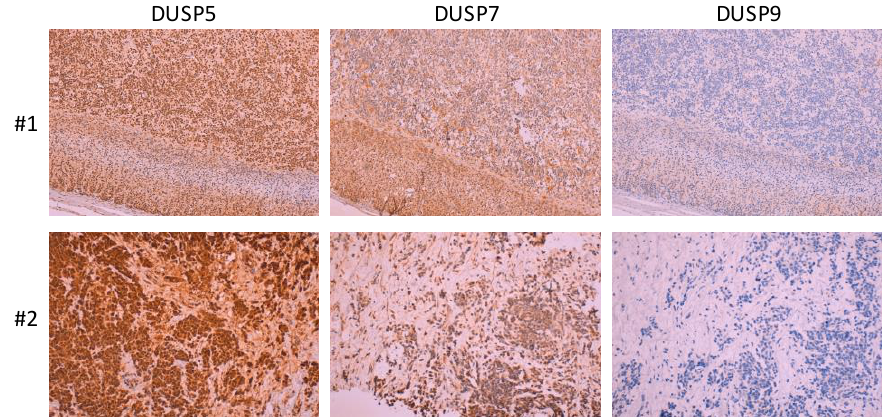
Figure 3. Immunostaining of selected MKPs from tissue sections from two NB tumors (#1: Stage I, unknown MYCN status, low-risk; #2: Stage IV, metastatic, MYCN amplification, high-risk). Representative staining patterns are shown. DUSP5 and DUSP7 mostly showed high-moderate immunoreactivity, whereas DUSP9 mostly displayed low immunoreactivity (magnification is × 100). Immunostaining was performed as described in [67].